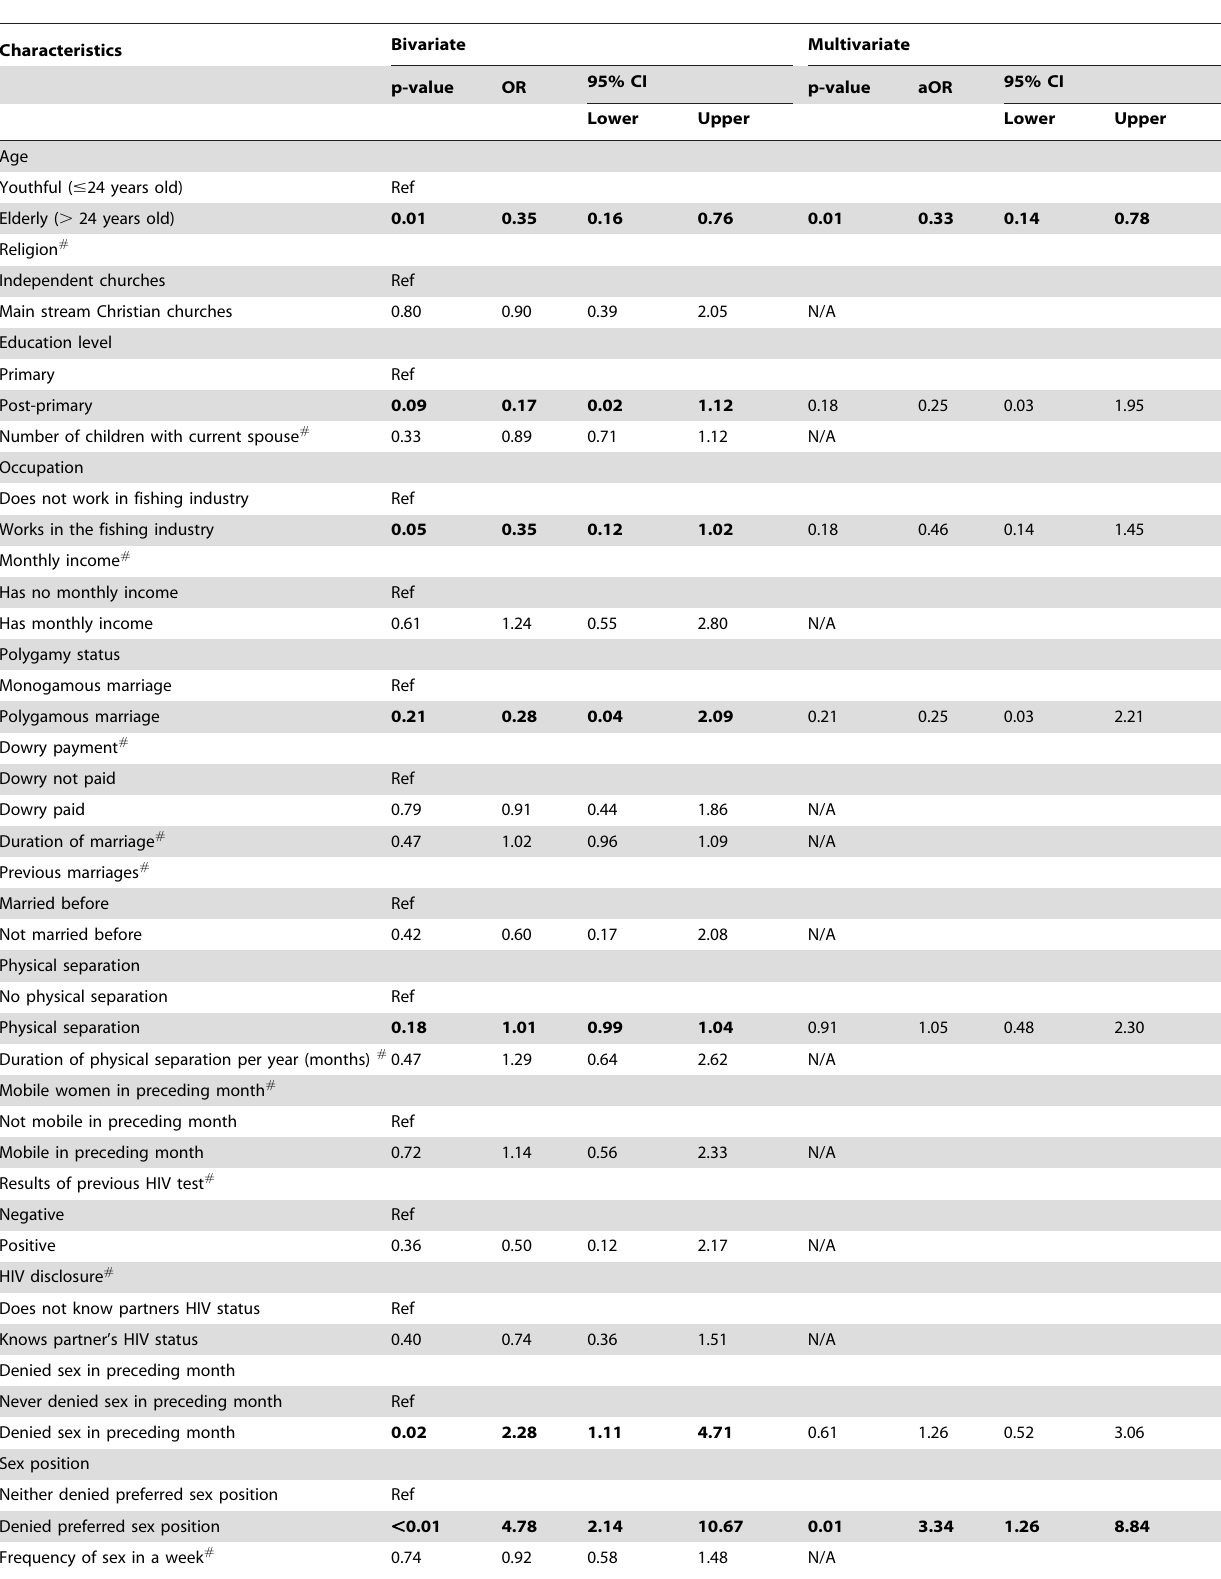
Table 3. Predictors of women’s involvement in extra-marital partnerships among married couples in the fishing communities along Lake Victoria in Kisumu